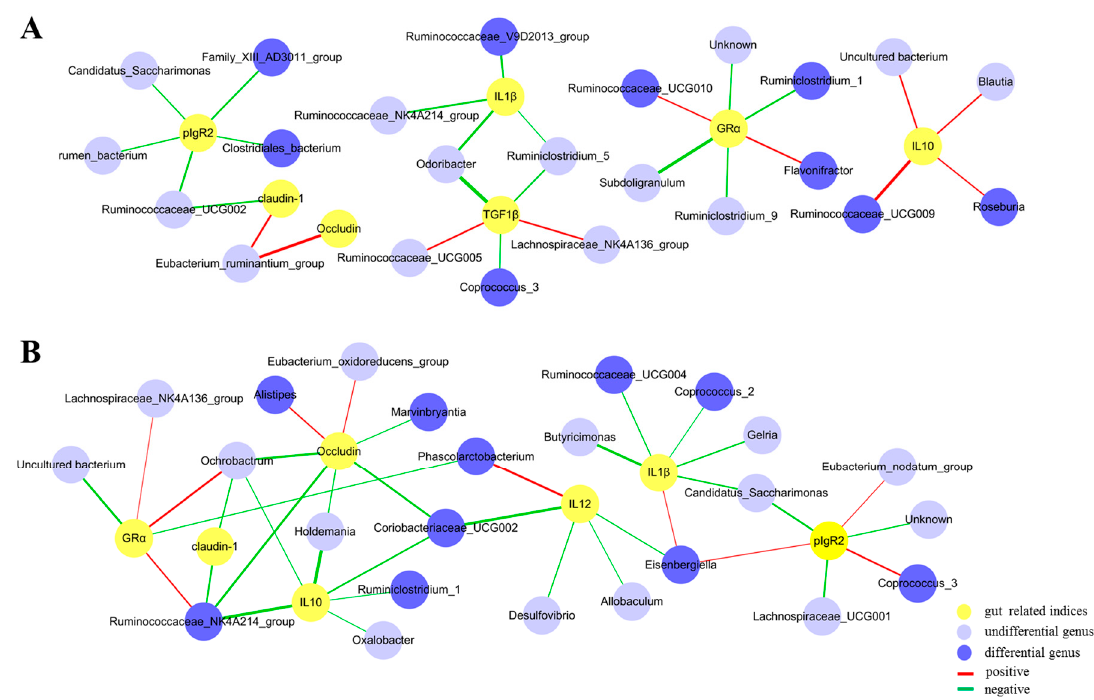
Figure 6. Correlation analysis between microbiota abundance and gut-related indices. Spearman’s rho non-parametric correlation was applied, and significant relationships with q < 0.05 are shown. ( A ) Correlation between the microbiota and gut-related indices in WW groups. Yellow nodes: Gut-related indices, referring to immune and tight junction-associated gene expression in WW groups. Blue nodes: Differential genus, referring to the genera that significantly differed between the groups (WW vs. CW) or markedly increased with age (day 58 vs. 82) in WW groups. Light blue nodes: Undifferential genus, referring to genera that were not significantly different between the groups (WW vs. CW) or did not markedly increase in abundance with age (day 58 vs. 82) in WW groups. ( B ) Correlation between the microbiota and gut-related indices in CW groups. Yellow nodes: Gut related indices, referring to immune and tight junction-associated gene expression in CW groups. Blue nodes: Differential genus, referring to the genera that significantly differed between the groups (WW vs. CW) or markedly increased with age (day 58 vs. 82) in CW groups. Light blue nodes: Undifferential genus, referring to the genera that were not significantly different between the groups (WW vs. CW) or did not markedly increase in abundance with age (day 58 vs. 82) in CW groups. Red lines indicate positive correlations between nodes (r ≥ 0.4), and green lines indicate negative correlations (r ≤ − 0.4). The thickness of the lines is proportional to the obtained r values. CW, cold water group; WW, warm water group.